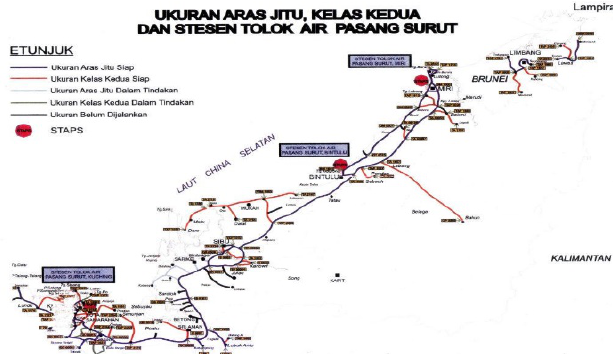
Figure 3. The unified precise leveling lines of